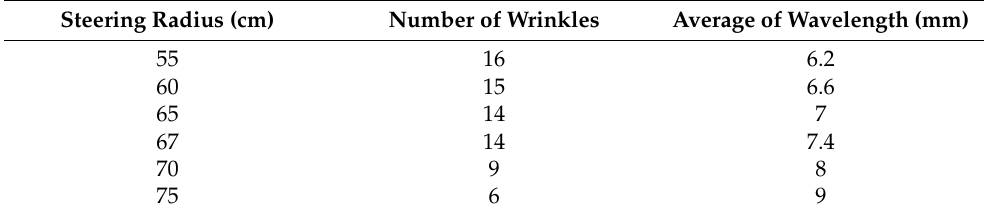
Table 2. Measurement results (the number of wrinkles and the average length of wrinkles in each radius).